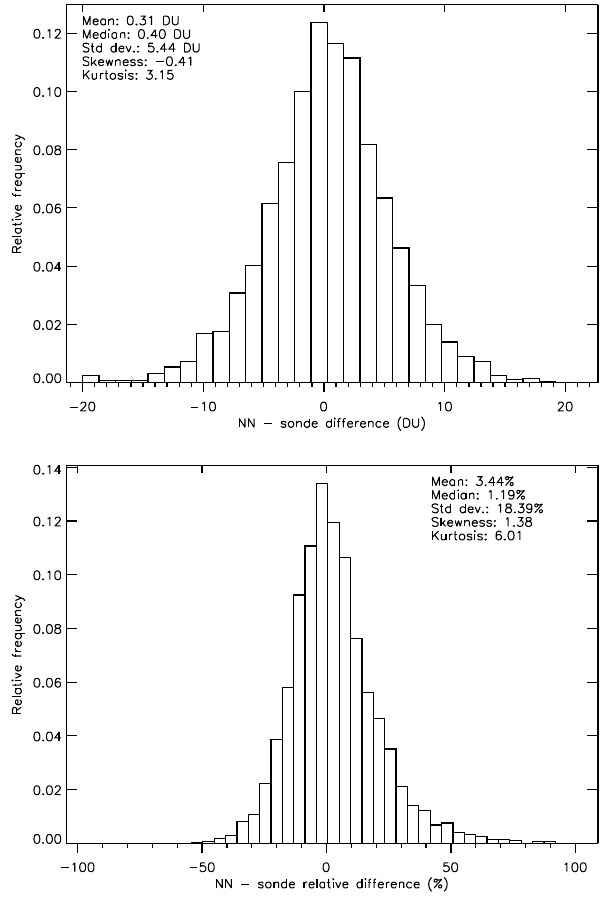
Fig. 3. Histograms of the absolute (top) and relative (bottom) dif- ferences between the retrieved and the target tropospheric ozone columns.